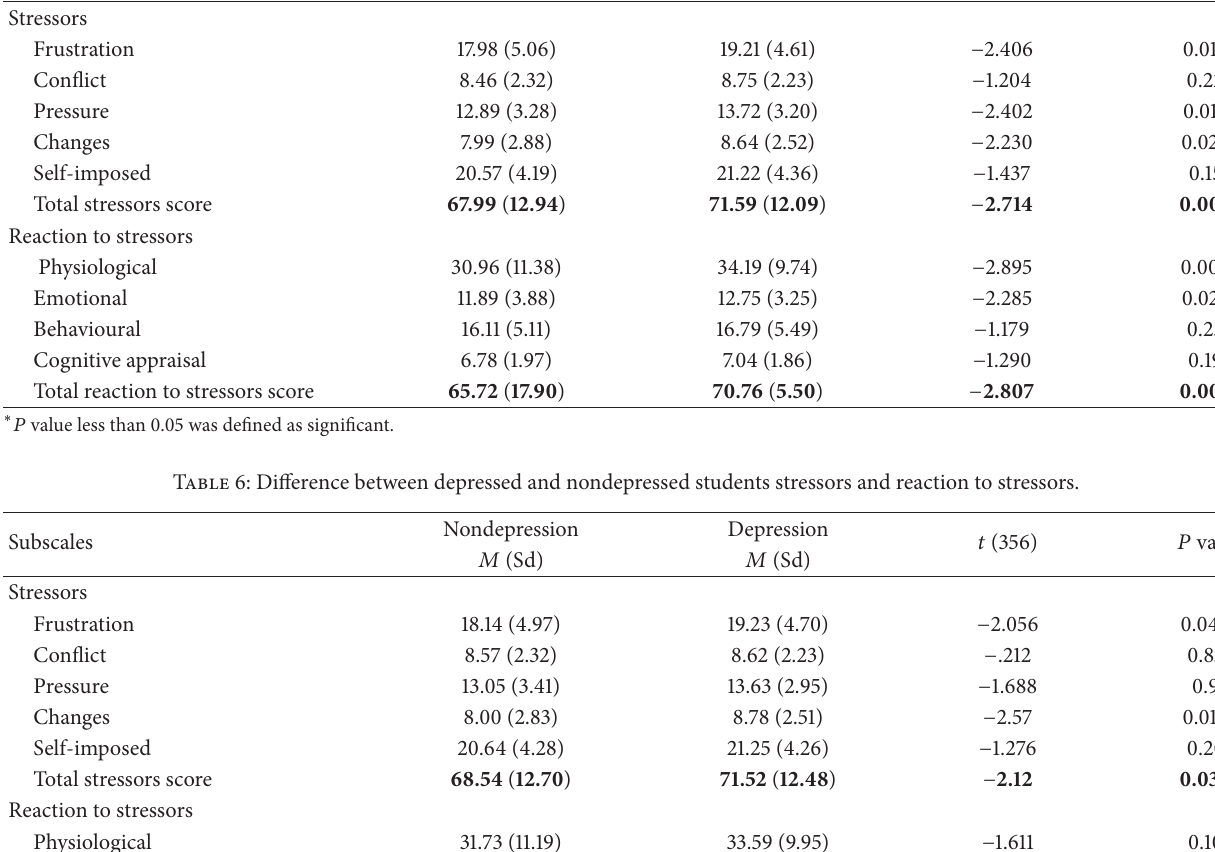
Table 5: Difference between anxious and non-anxious students’ stressors and reaction to stressors. Subscales